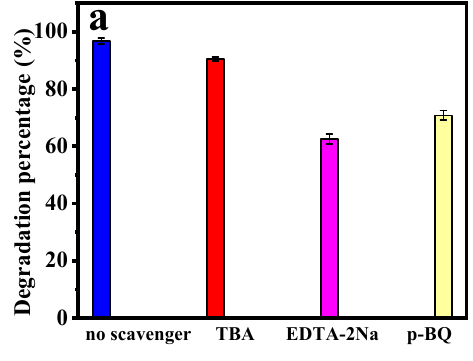
Figure 10. Suggested pathways for ciprofloxacin degradation in CN/La-N-TiO 2